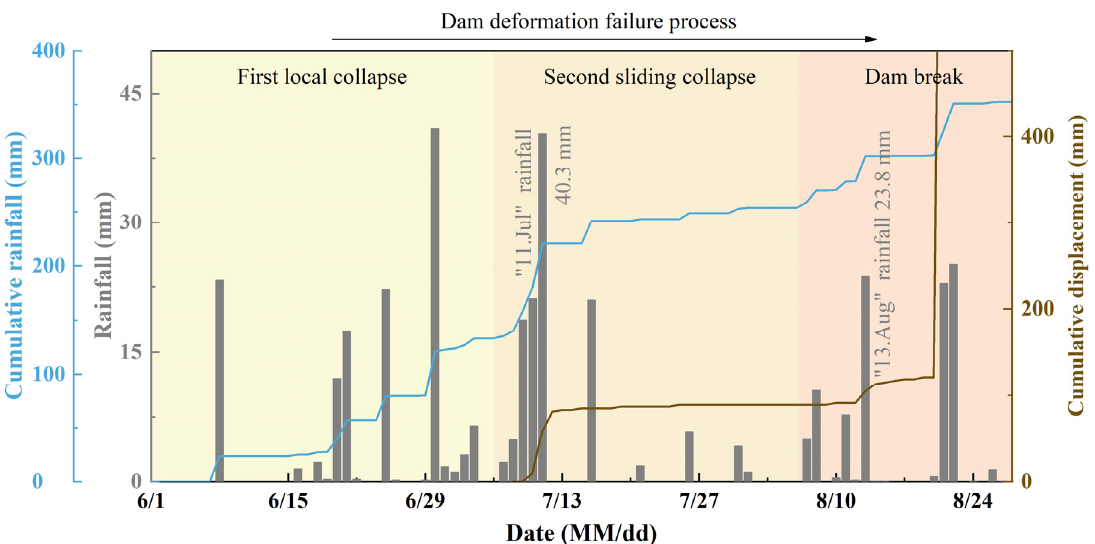
Figure 13. Regional rainfall data and cumulative displacement for typical cases of failed dams in 2018, including the process of dam deformation and failure.